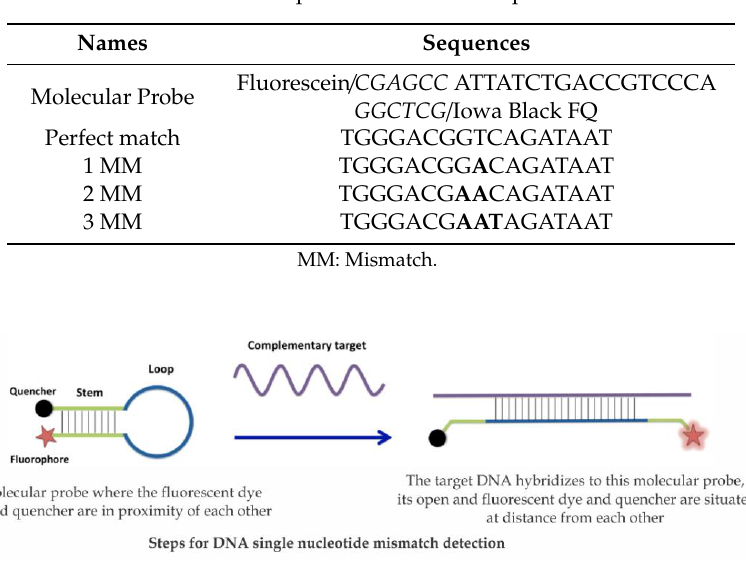
Table 1. DNA sequences used in the experiments.